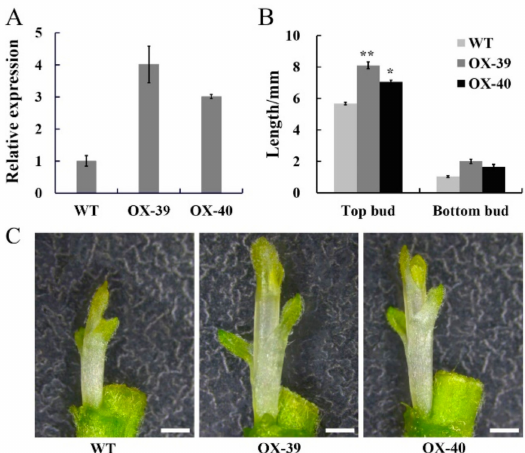
Figure 5. CmSWEET17 overexpression lines promote bud growth in Chrysanthemum morifolium . ( A ) Relative CmSWEET17 expression in WT (wild-type) and overexpression lines OX-39 and OX-40 and ( B ) the length of the bud following treatment of two-node stem. Data are represented as the mean ± SE of n = 10. ( C ) Phenotype of axillary bud growth in WT, OX-39, and OX-40. Scale bars, 1 mm. * p ≤ 0.05 and ** p ≤ 0.01 vs.